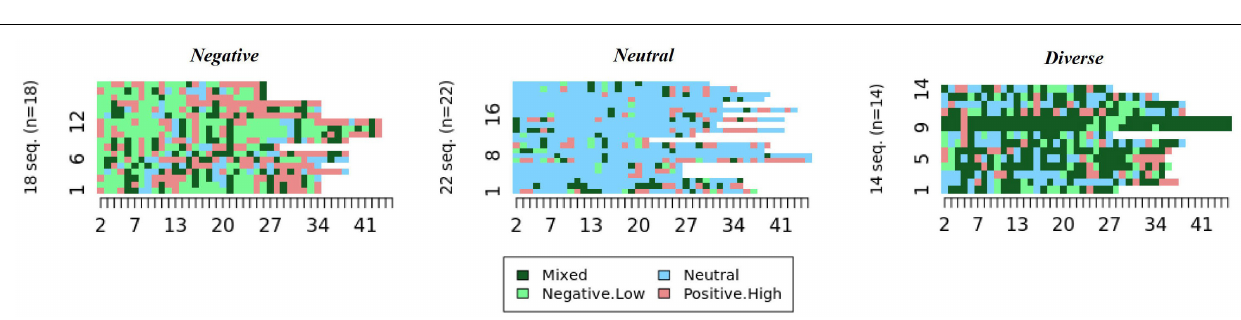
Figure 4 confirm that the neutral profile students